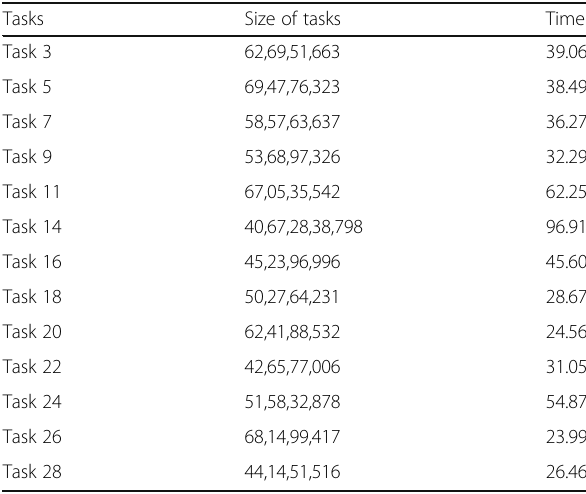
Table 1 Cybershake seismogram synthesis tasks Tasks Size of